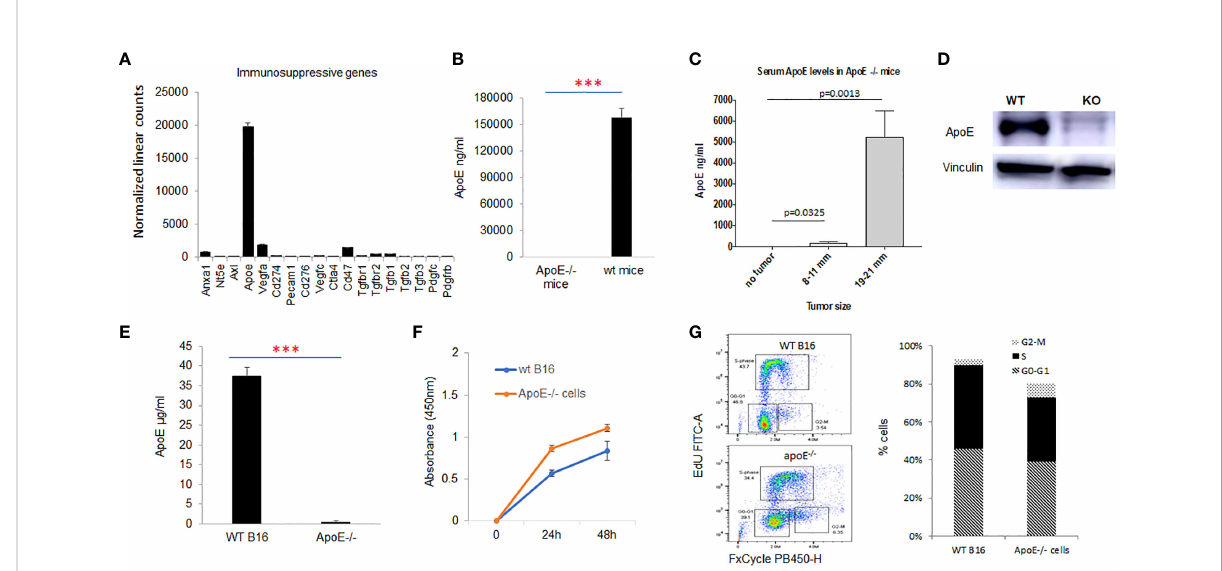
FIGURE 1 ApoE is the most highly expressed immune suppressive gene in the melanoma B16-F10 cell lines and apoE serum levels rise with tumor growth in vivo. (A) mRNA expression as revealed by nanostring nsolver Pancancer immune pro fi ling, of the immune suppressive marker genes in B16F10 cells (n=6). (B) ApoE expression was undetectable in the serum of apoE knockout (apoE-/-) mice, but present at high levels in wild type (C57/ BL6) mice with ELISA assay. (C) ApoE knockout mice were inoculated with 10^4 wild type (B16F10) cells and serum levels of apoE increased over time with increasing tumor size. (D) Validation of apoE gene knockout in B16F10 cells by CRISPR-Cas9 gene deletion. The level of apoE protein expression was measured in WT B16F10 and the corresponding apoE-/- clone by Western Blot. (E) Equivalent numbers of WT and apoE-/- B16 cells were plated and apoE levels released into culture media were quanti fi ed by ELISA at 48hr. ApoE is secreted at high levels in WT B16 cells and is not detectable in the apoE-/- cell line. (F) To evaluate whether targeting apoE in fl uenced cell viability and proliferation, 5x10^4 WT (n=6) or apoE-/- B16 cells (n=6) were grown in 12-well plates and proliferation rates were measured at 24hr and 48hr by MTT assay. There is no statistically signi fi cant difference in cell proliferation rate between the two groups. (G) Cell cycle distribution was determined in WT and apoE-/- B16 cells. The various phases of the cell cycle are differentiated in the fl ow cytometry plot on the left: G0-G1 is the pre- synthesis phase, S-phase cells are undergoing active DNA synthesis and G2-M cells are preparing for mitosis. Bar graphs represents the percentage of cells in G0-G1, S and M phase of the cell cycle. Cell counts and cell cycle distribution indicate that WT and apoE-/- B16 cells proliferate at equivalent rates. Data are representative of three independent experiments. Results are expressed as mean score ±SD. ***p<0.001, determined by unpaired two-tailed Student ’ s